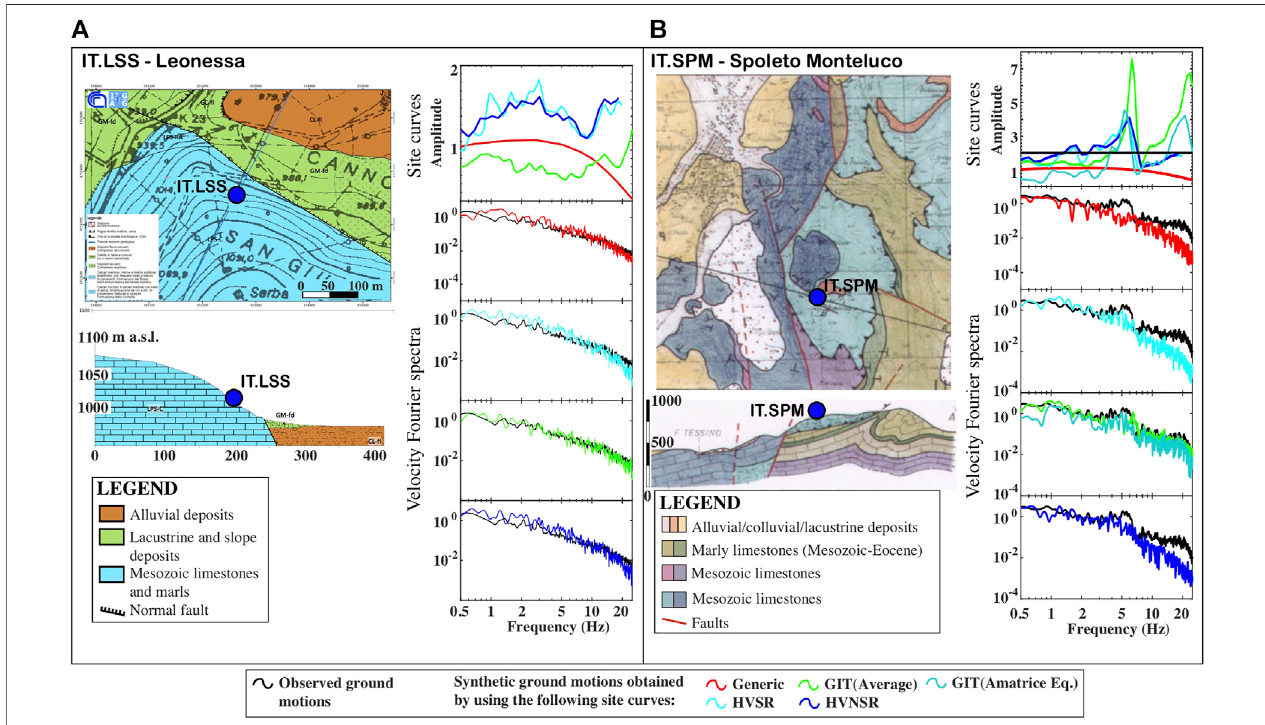
FIGURE8| SimulationresultsandrecordsofAmatriceearthquakeatstationsLSS[panel (A) ]andSPM[panel (B) ],installedonrockandrelatedtositeclassA.Foreach one, we show: the geological map and pro fi le furnished in the ITACA database; the applied generic and empirical site curves at each station (consistently with Figure 2 ); Synthetic velocity Fourier spectra were obtained using the different site curves, and recorded velocity Fourier spectra (geometric mean of the two horizontal components).